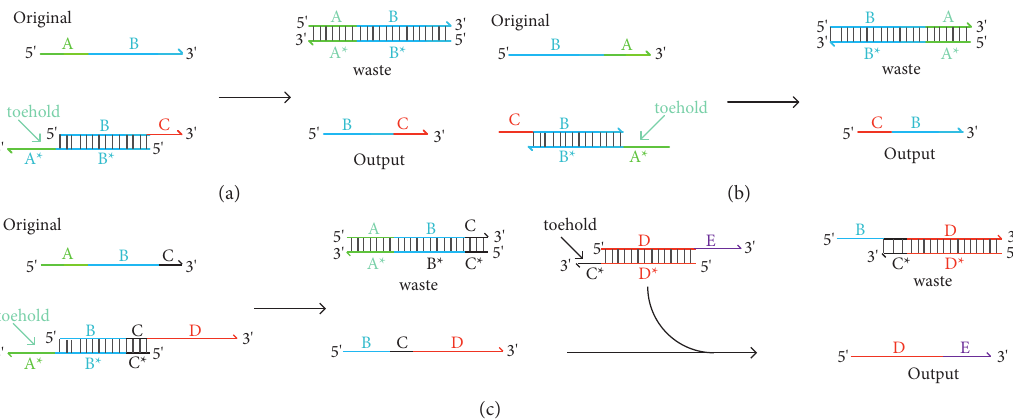
Figure 3: Basic reaction principle of DSD. (a) DSD starts at the 3’ terminal toehold of the substrate. (b) DSD starts at the 5’ terminal toehold of the substrate. (c) Cascade DSD.